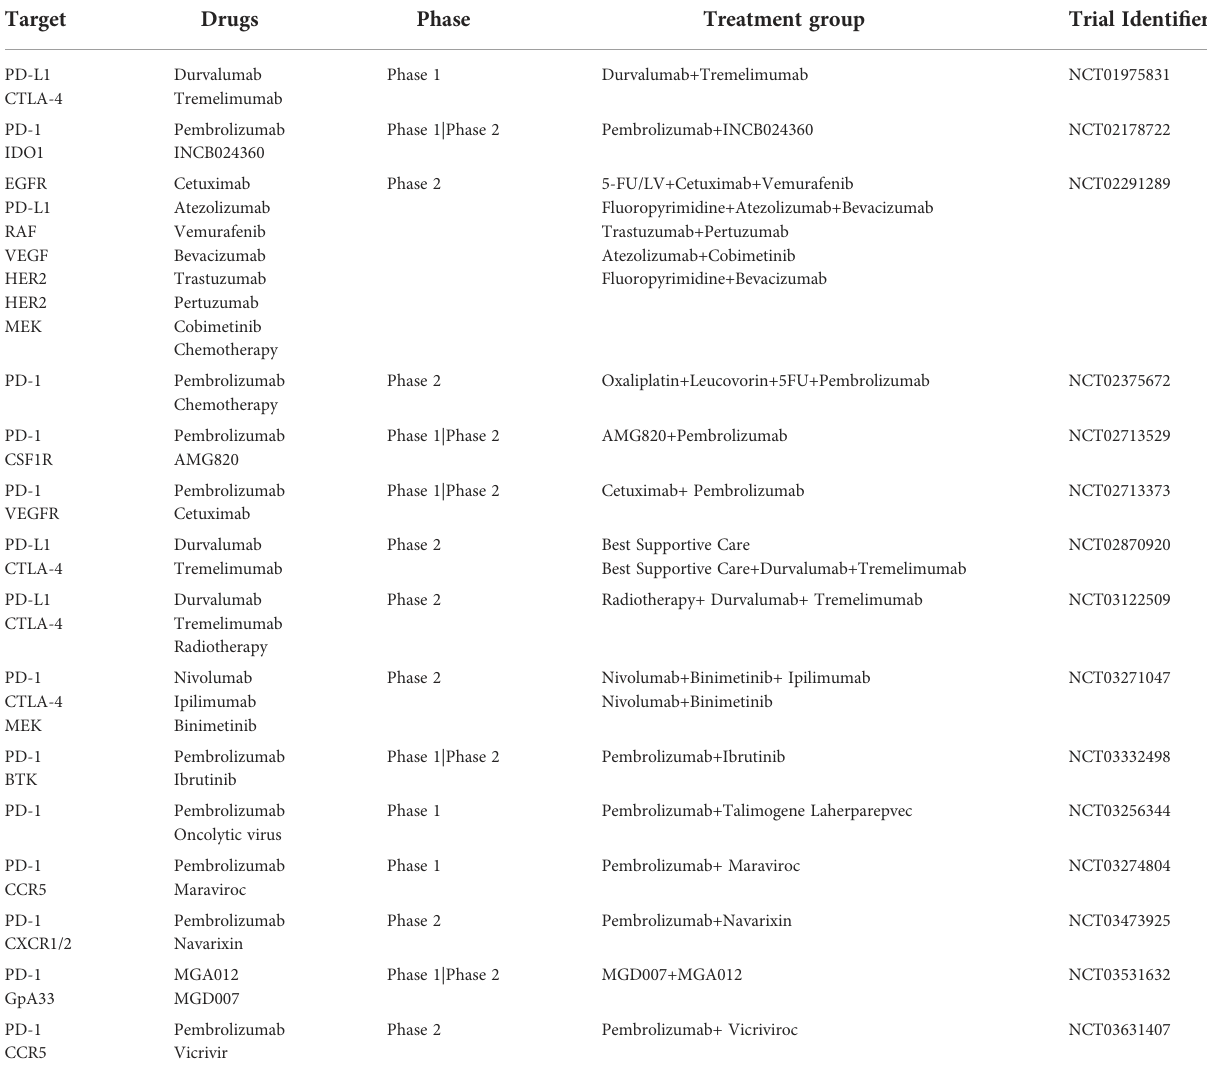
TABLE 2 Trials using combination immunotherapies for